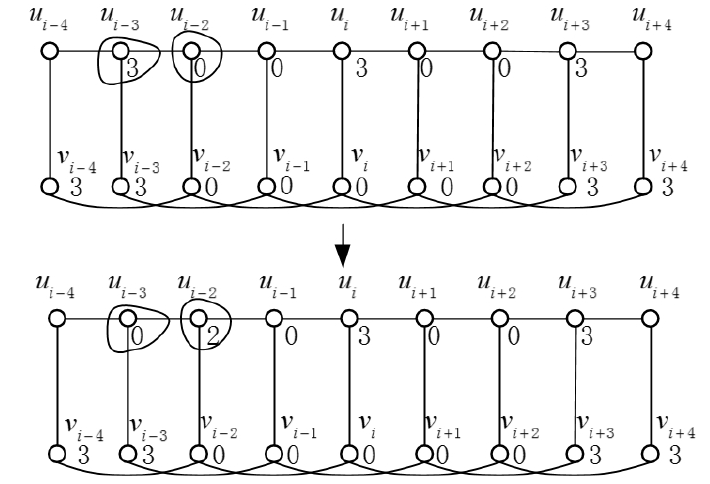
Figure 1. Construct a function f (cid:48) from f used in Lemma 2.